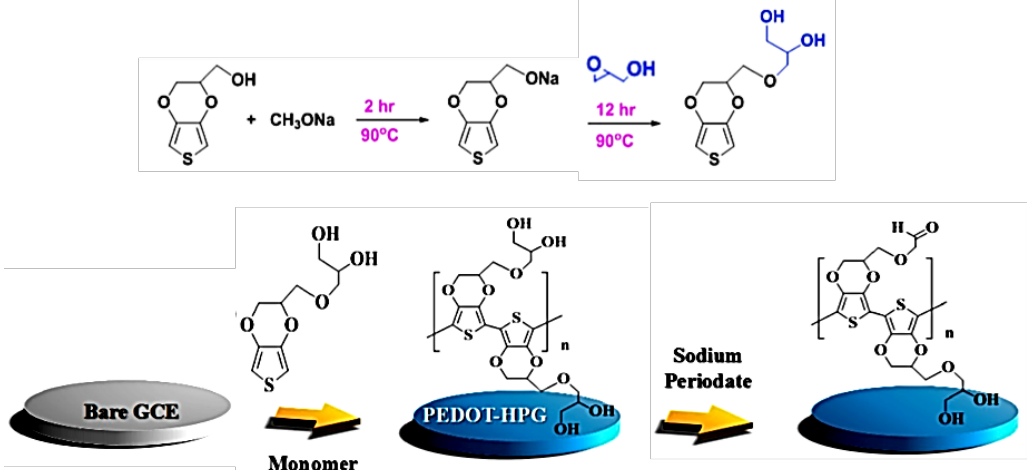
Figure 2. Synthesis route of the new EDOT-based monomer (top), and electrochemical synthesis of PEDOT– graft –HPG. Reproduced with permission [49].